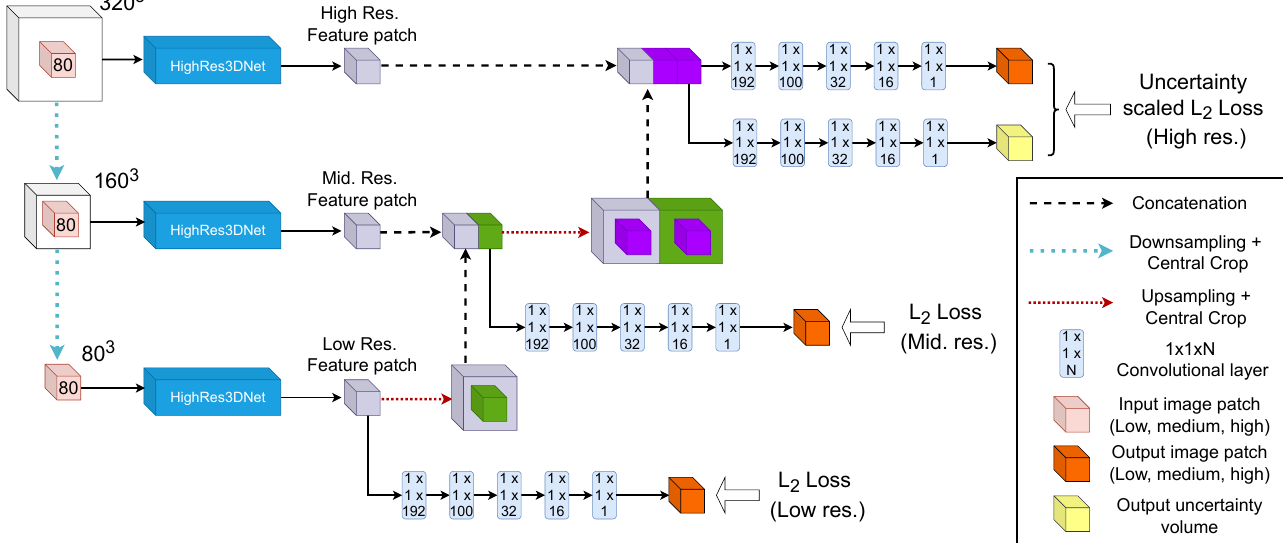
Figure 1. MultiRes unc network architecture. T 1 and T 2 magnetic resonance (MR) patches from the same subject are fed into each independent instance of the HighRes3DNet architecture [20] at various levels of resolution and field of view. A downsampling operation followed by a central crop at every level ensures the patch size is maintained while obtaining patches with different fields of view and resolution. Lower level feature maps are concatenated to those at the next level until the full resolution level, where these concatenated feature maps are passed through two branches consisting of a series of 1 × 1 × N convolutional layers: one resulting in a high-resolution synthesised pseudo computed tomography (pCT) patch and the other in the corresponding voxel-wise heteroscedastic